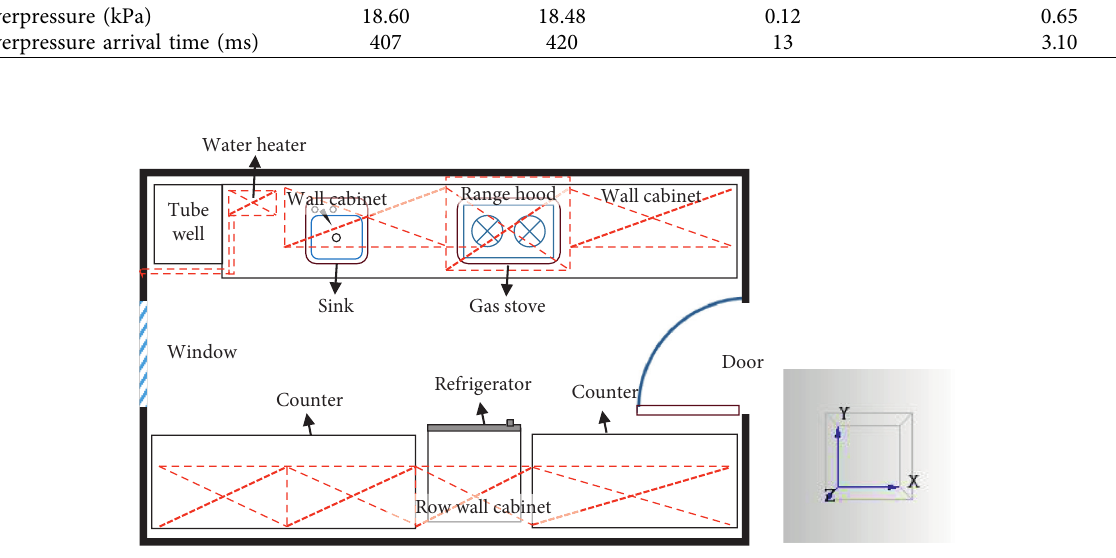
Table 3: The comparison results between experiment and simulation. Explosion parameters